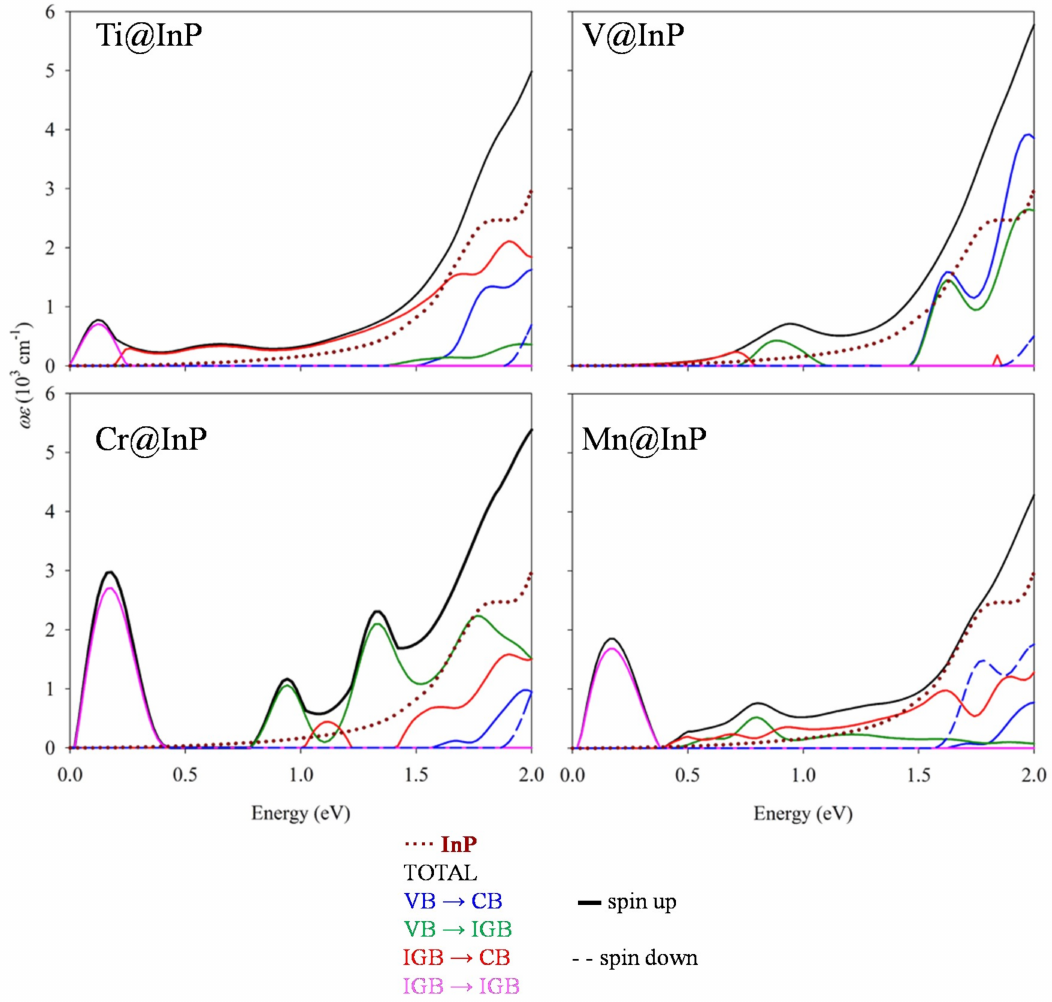
Figure 8. Partial contributions to the imaginary part of the dielectric function ε , multiplied by the frequency ω , for